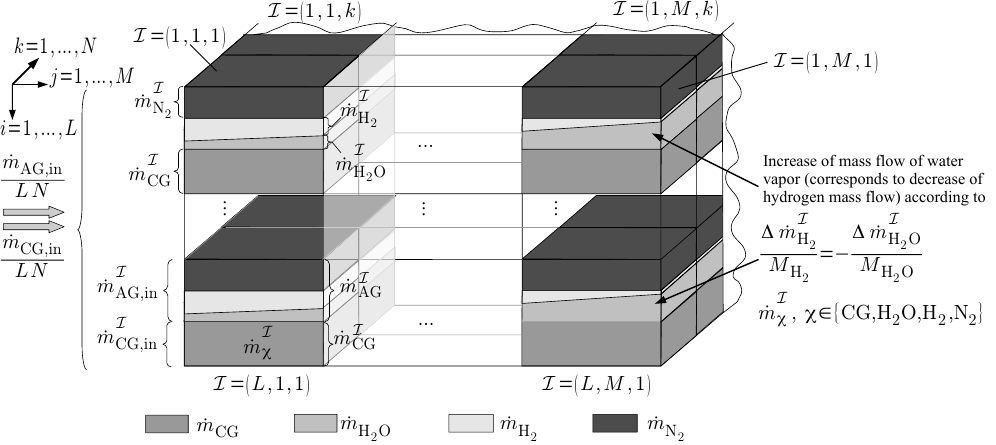
Figure 4. Local mass flow balances in the semi-discretized fuel cell stack